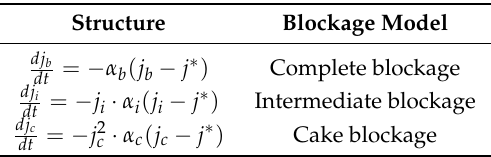
Table 5. De Bruijn extended fouling models